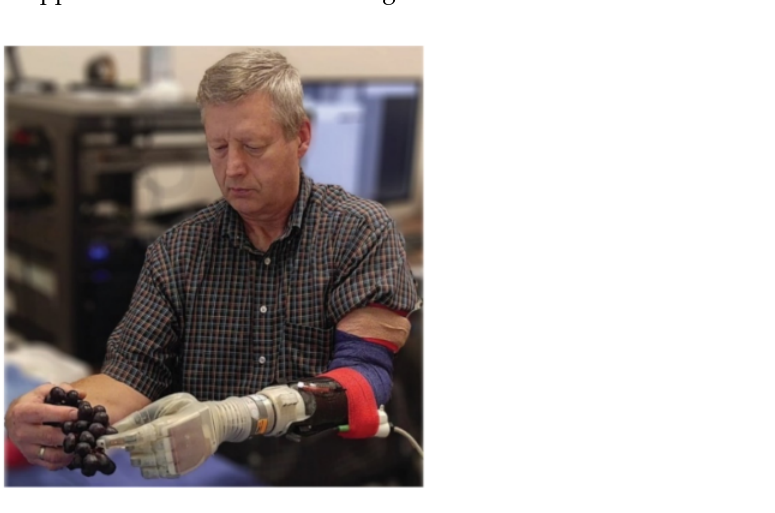
Figure 5. Plucking a grape by using the LUKE arm without smashing it is a process that would be incredibly challenging without tactile feeling. (Photo courtesy from the Center for Neural Interfaces, University of Utah, Salt Lake, UT,